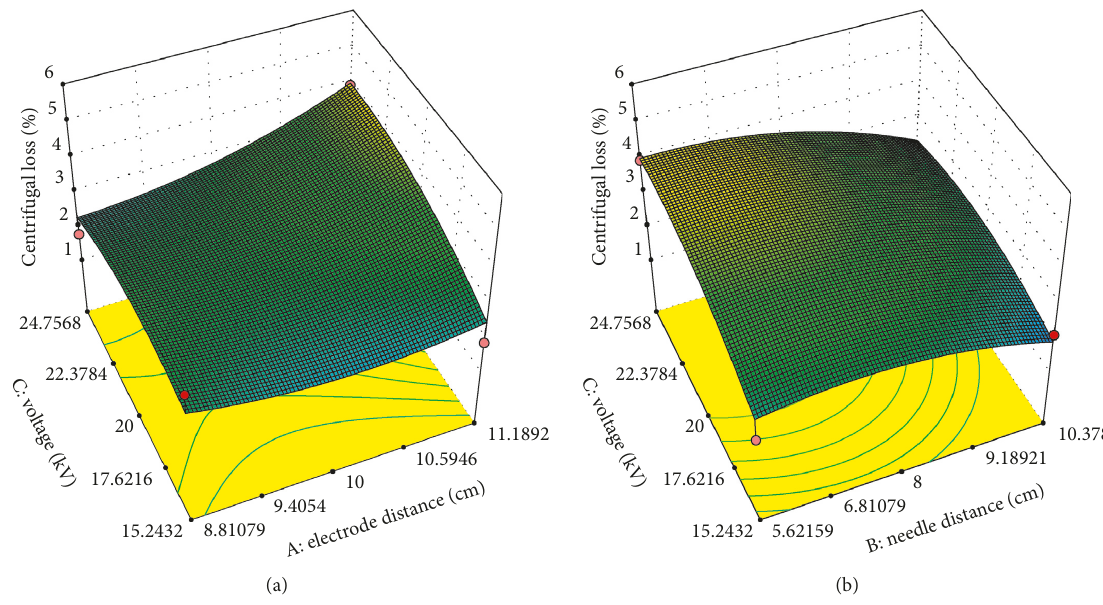
Figure 6: Response surface analysis of centrifugal loss. (a) Electrode distance and voltage; (b) Needle distance and